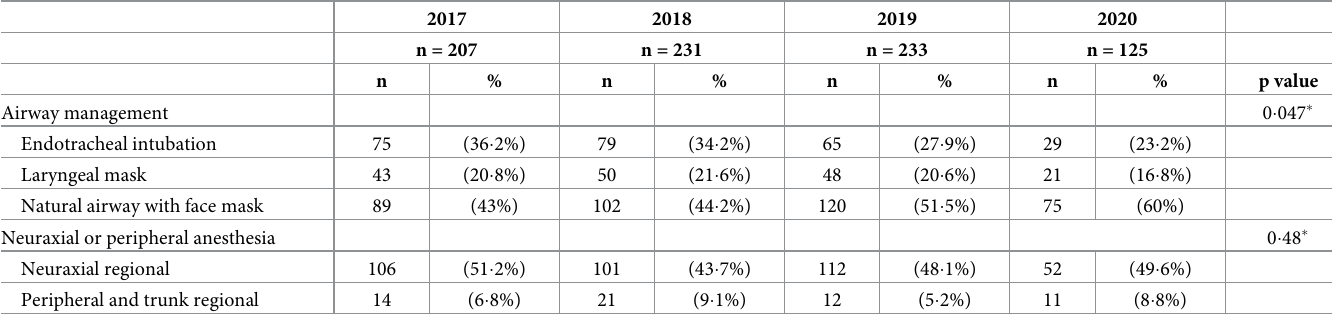
Table 4. Anesthesia